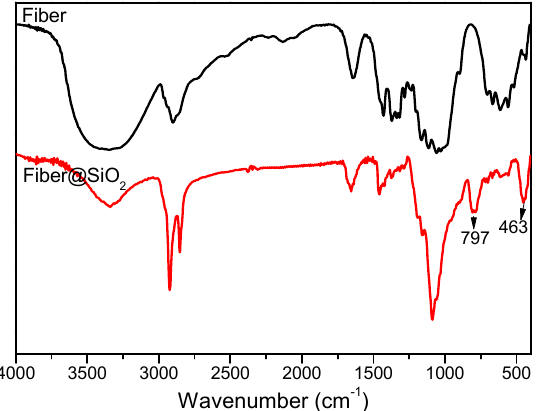
Figure 2. FT-IR spectra of raw cellulose fiber and SiO 2 modified cellulose fiber.